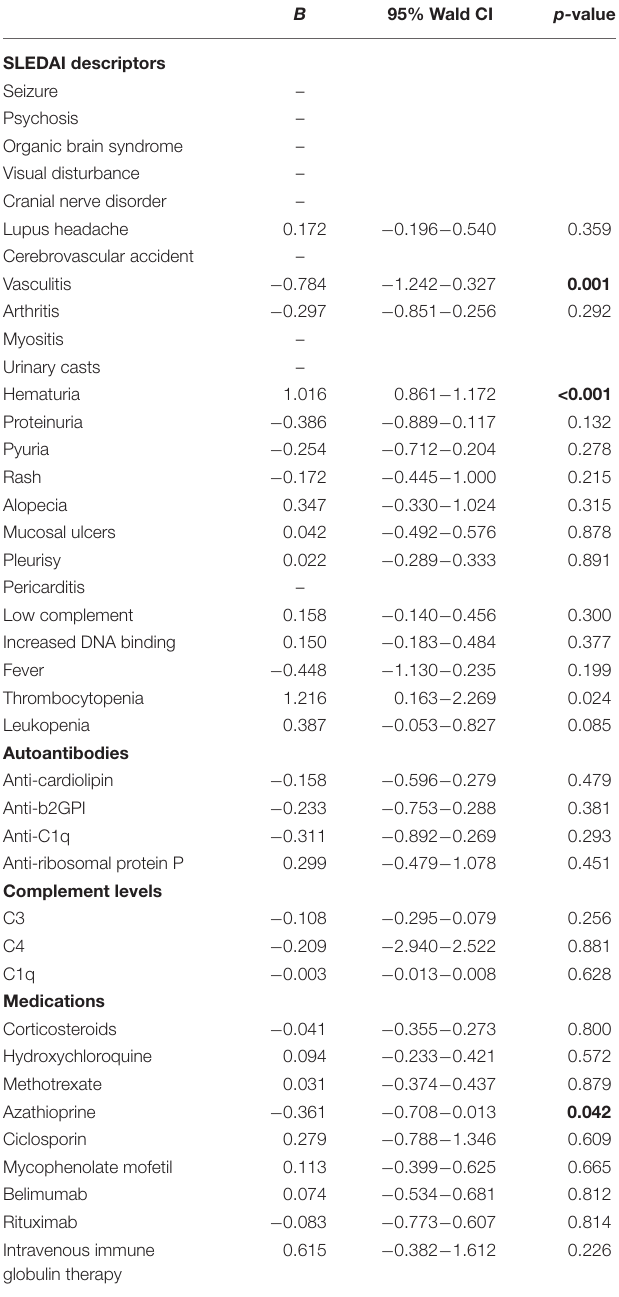
examine MPV within SLE, we categorized patients into “small,” TABLE 3 | Impact of disease activity, autoantibodies, complement levels, and medications on mean platelet volume (MPV) variations, analyzed by generalized “normal,” or “large” size MPV categories, based on the reference estimating equations (GEE). interval (9.4–12.6 fL). Patients with MPV values of < 9.4 fL were considered as small, between 9.4 and 12.6 fL normal and > 12.6 B 95% Wald CI